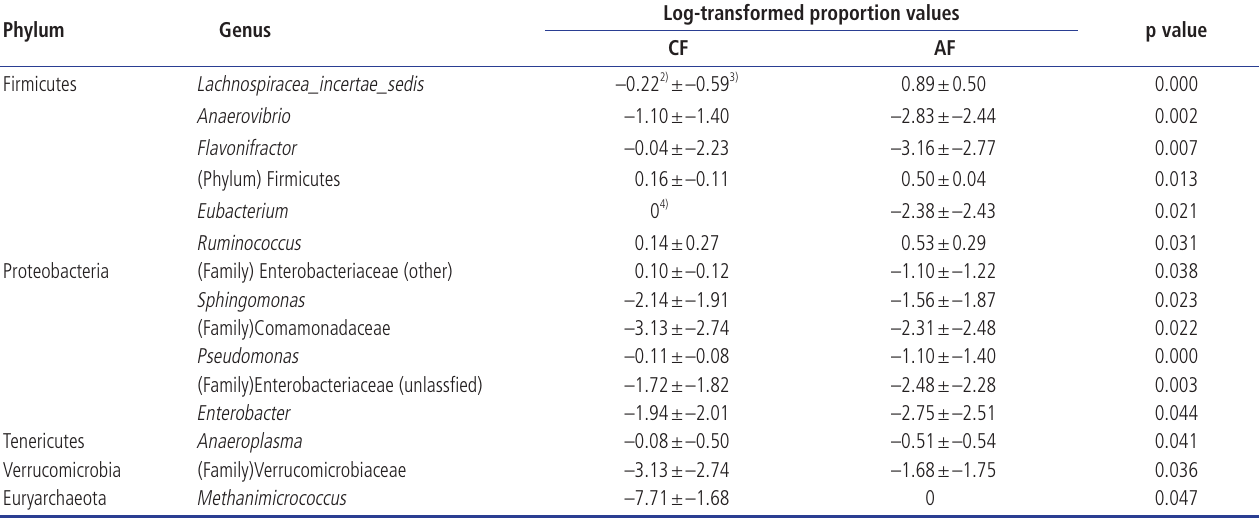
Table 3. The 15 genera with significantly different abundance in the rumen of goats fed at a completed feed (CF) or all forage (AF) diet 1)